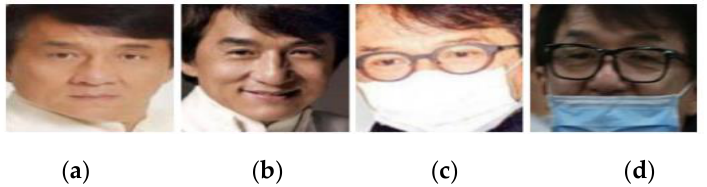
Figure 17. Example images from the RMFRD (real-world masked face recognition dataset) dataset: ( a , b ) typical images, ( c , d ) masked images. 3.